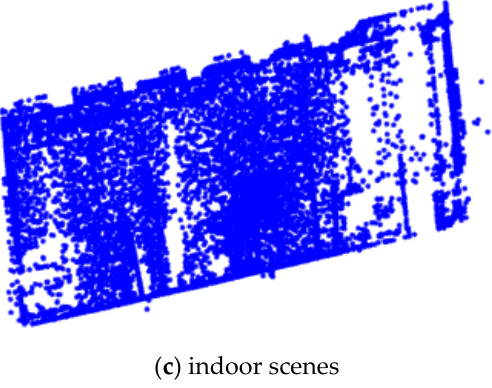
Figure 15. Point cloud registration results.